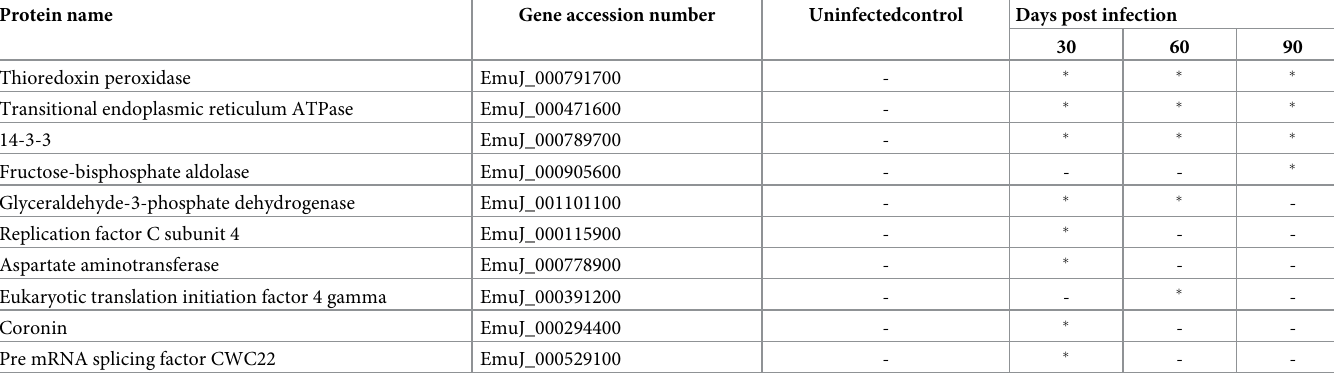
Table 2. Summary of parasite proteins in serum-derived exosomes from E . multilocularis -infected mice. Protein